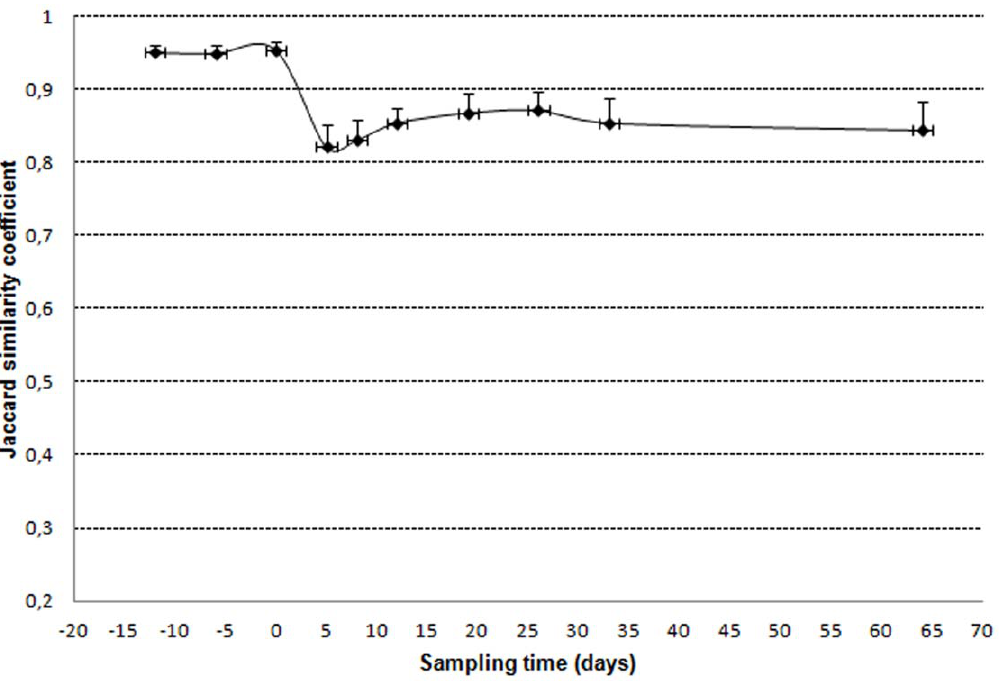
Figure 7. Change of species after the AMC exposure.